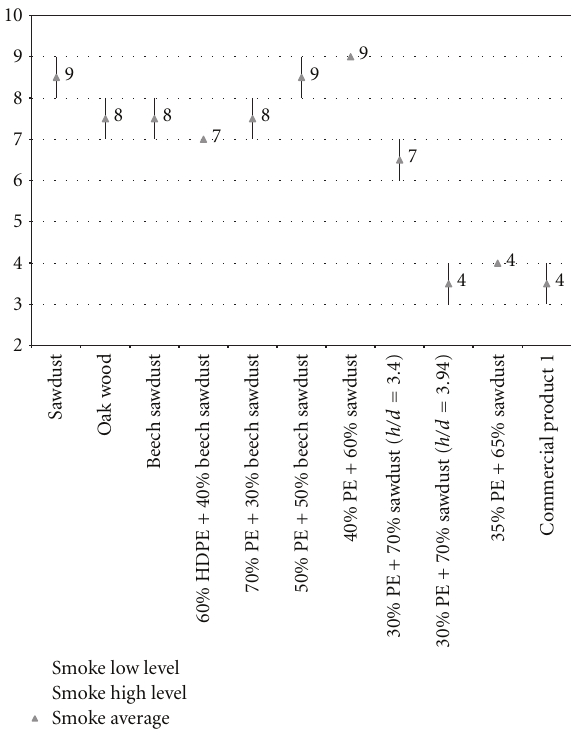
F 5: Smoke number level for each